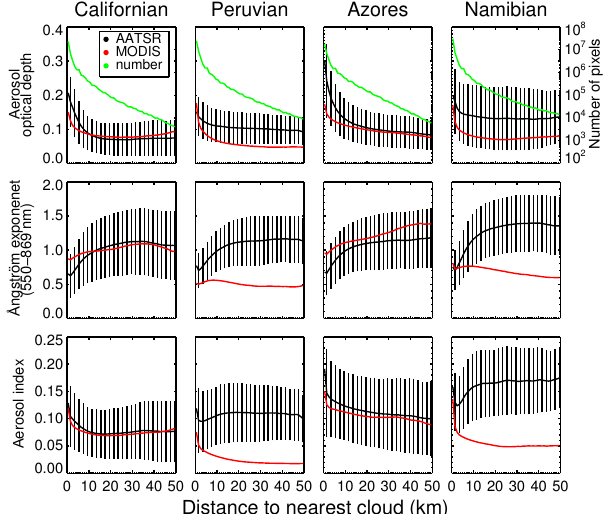
Figure 2. Mean aerosol optical depth as a function of the distance to the nearest cloud mask averaged over 1km width bins. Rela- tionships are plotted using AATSR-ORAC (black) and collection 6 MOD04 applied to MODIS–ORAC (red) for JJA 2008 data grouped into 10 ◦ × 10 ◦ regions off the coasts of California (20–30 ◦ N, 140– 130 ◦ W), Peru (10–20 ◦ S, 80–90 ◦ W), the Azores (15–25 ◦ N, 25– 35 ◦ W), and Namibia (10–20 ◦ S, 0–10 ◦ E). The number of AATSR pixels in each bin are plotted over the results (green). Error bars are denoted by the 1 standard deviation computed over the collection of AATSR retrievals within the